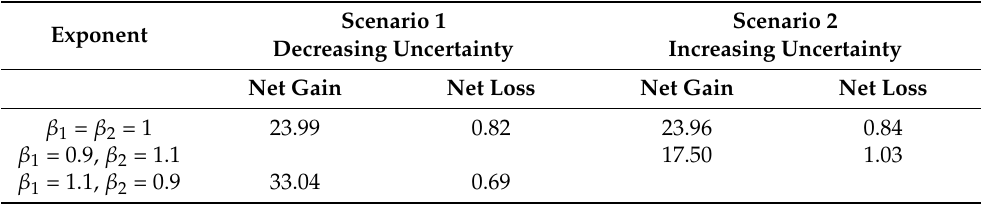
Table 5. Net gain and net loss by reallocating resources for two scenarios (using 10,000 samples) for resource reallocation (variance-decreasing Scenario 1 and variance-increasing Scenario